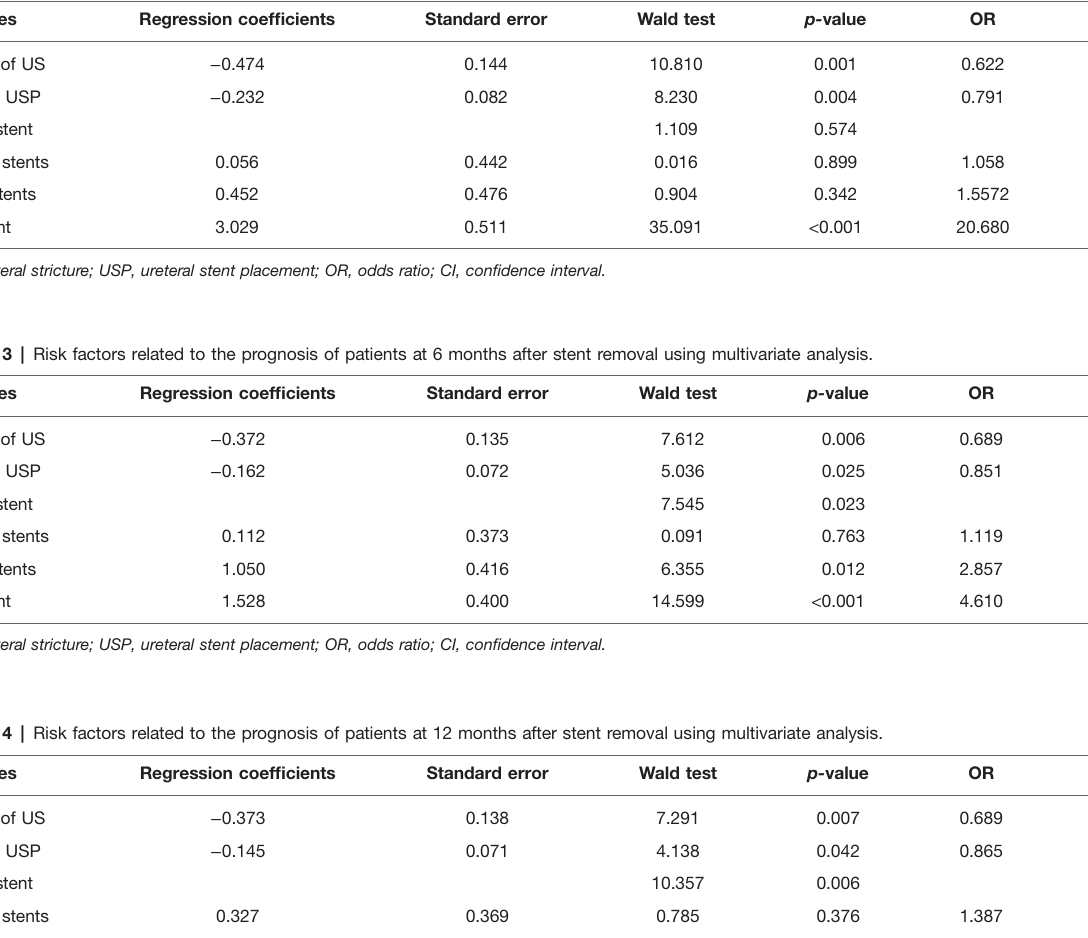
TABLE 2 | Risk factors related to the prognosis of patients at 1 month after stent removal using multivariate analysis.